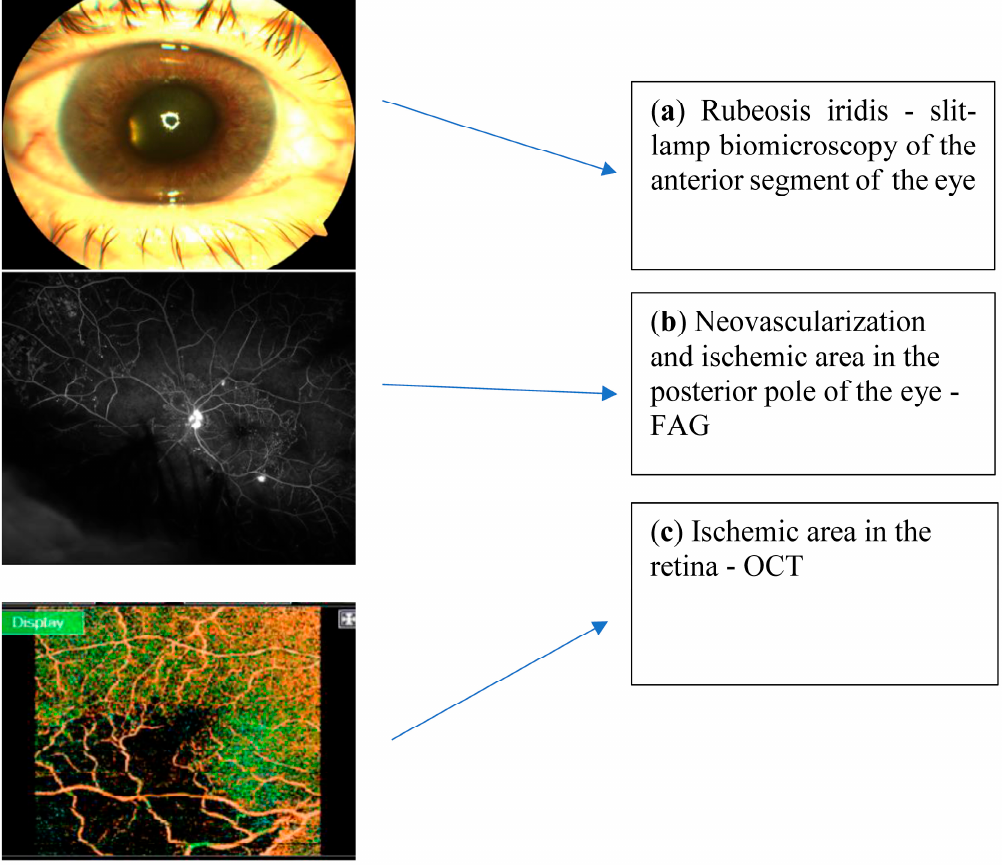
Figure 1. Pictures describing NVG ophthalmic diagnostics.